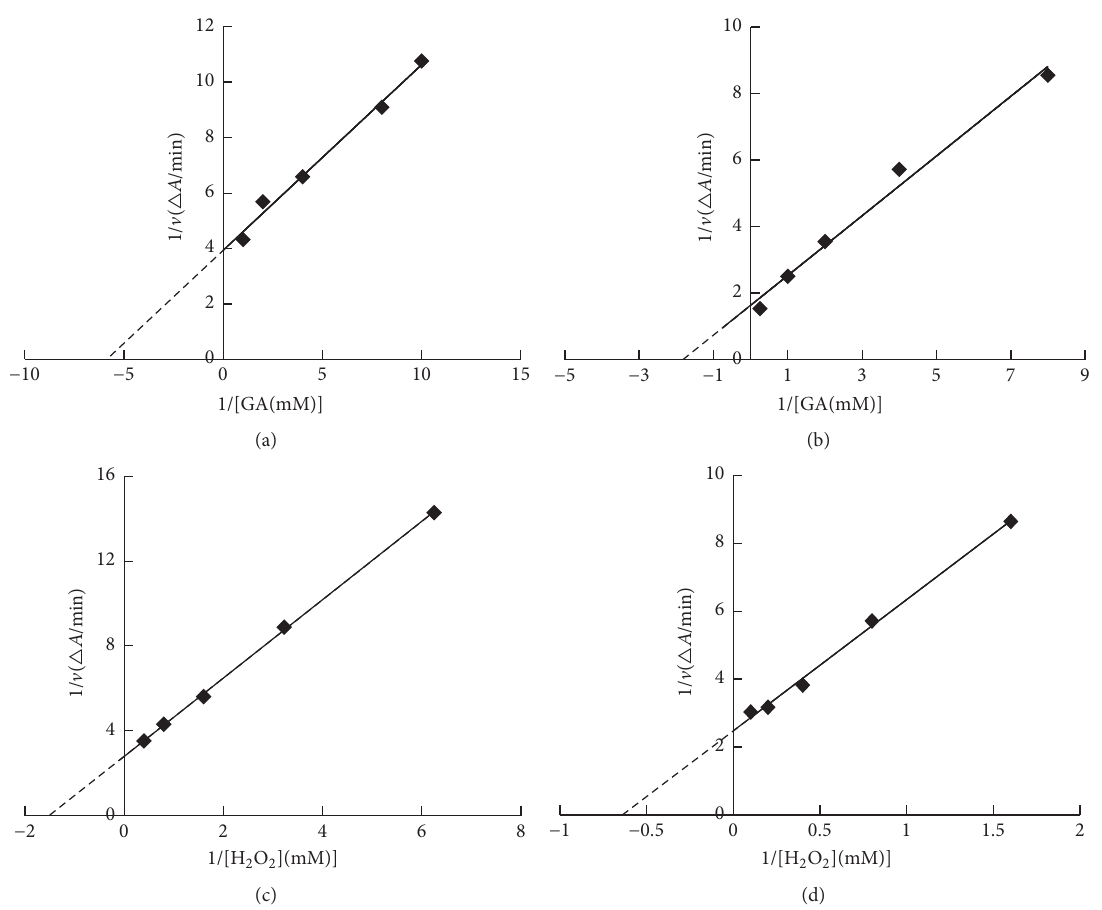
Figure 3: Lineweaver–Burk plot for the Michaelis–Menten constant. (a, c) Tg-HbI; (b, d) Tg-HbII.